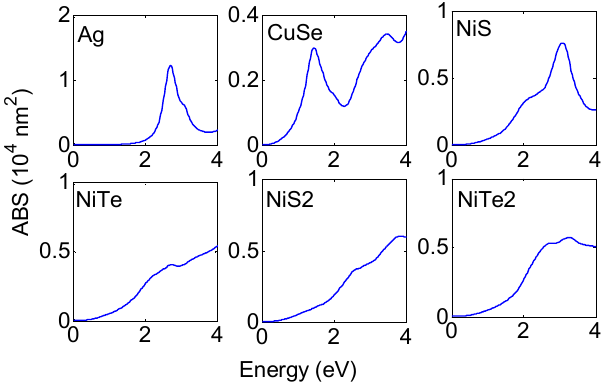
Figure 2. Absorption cross sections of different NP materials for 30 nm NP radius. CuSe and NiS NPs show pronounced resonance peaks. NiTe 2 NP resonates over the large spectral region of visible range while NiTe and NiS 2 NPs display extended ABS in a broad spectral range from the infrared to